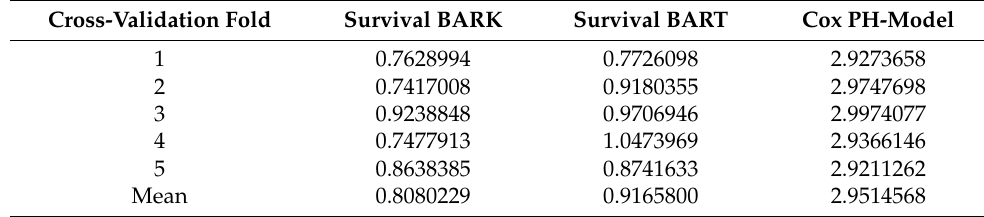
Table 1. RMSE from 5-fold cross-validation performance of Survival BARK, Survival BART, and Cox-PH Model on the simulated dataset.